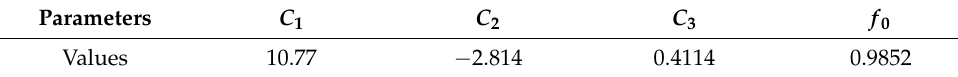
Table 2. Parameter values of the M-K+DF2012 model for the AA6061 tube. Parameters C 1 Values